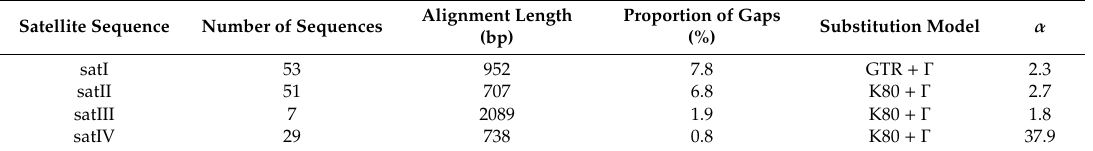
Table 5. Multiple-sequence alignment composition and selected substitution models of cervid satellite sequences.